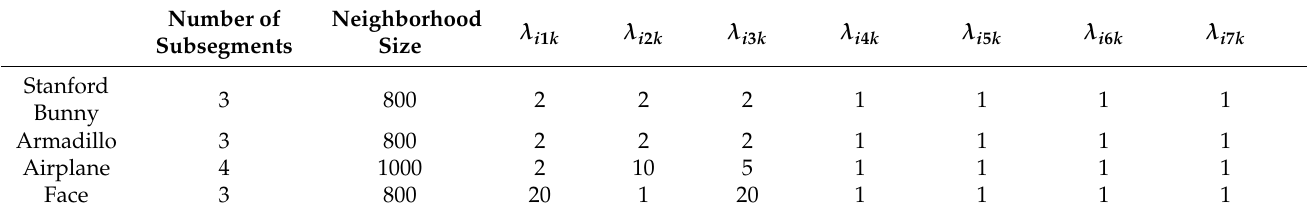
Table 4. Parameters of the λ -ICP algorithm for the case of impulse